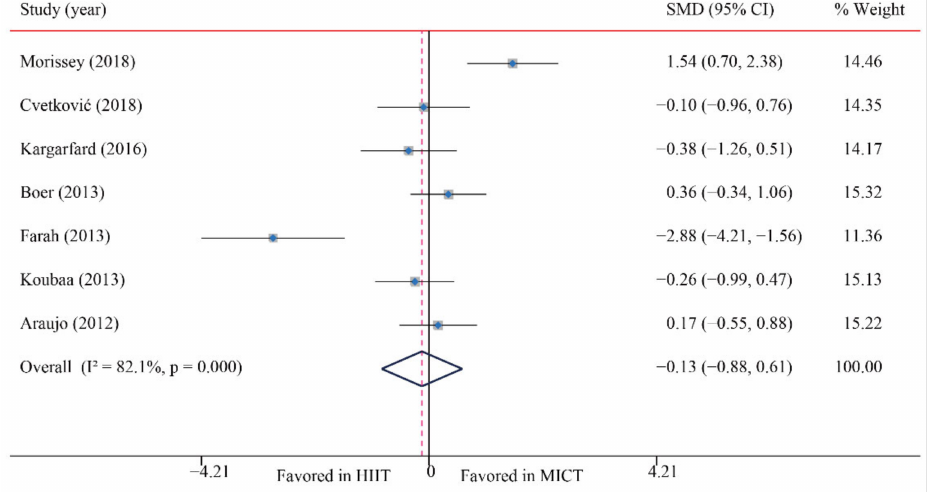
Figure 9. Effect of HIIT versus MICT on diastolic blood